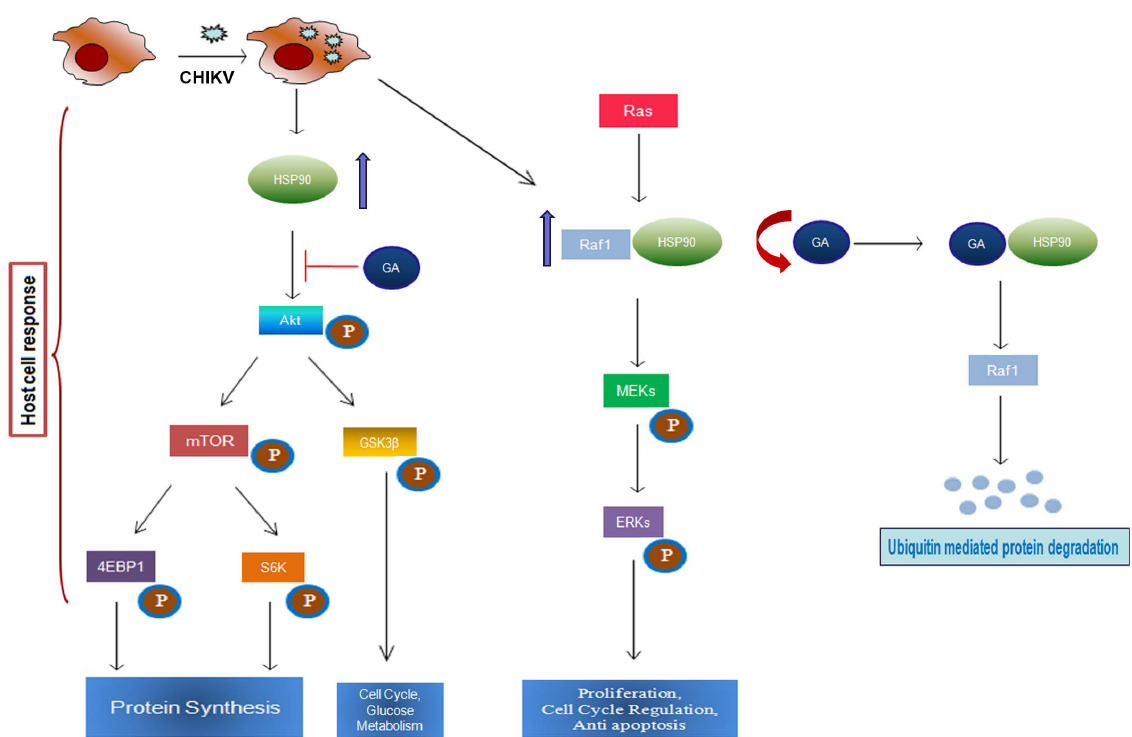
Figure 7. Schematic representation of the working model of the cellular signalling molecules in CHIKV infection. CHIKV infection results in the induction of Hsp90 associated client proteins like Raf1, Akt and various Akt substrates. GA treatment on CHIKV infected cells results in the degradation of Hsp90 associated client proteins which has been explained in the text.